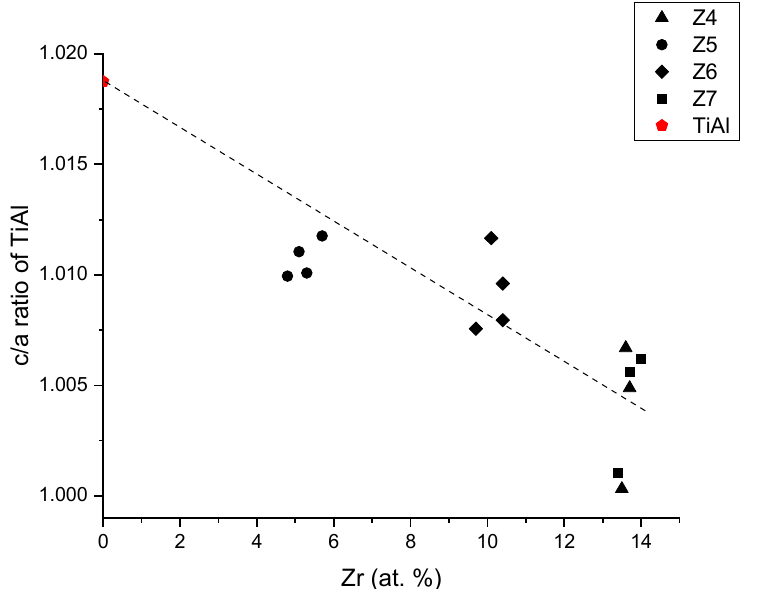
Figure 13. The c/a ratio of TiAl depending on the Zr content as determined by EPMA. Binary TiAl taken from [30].